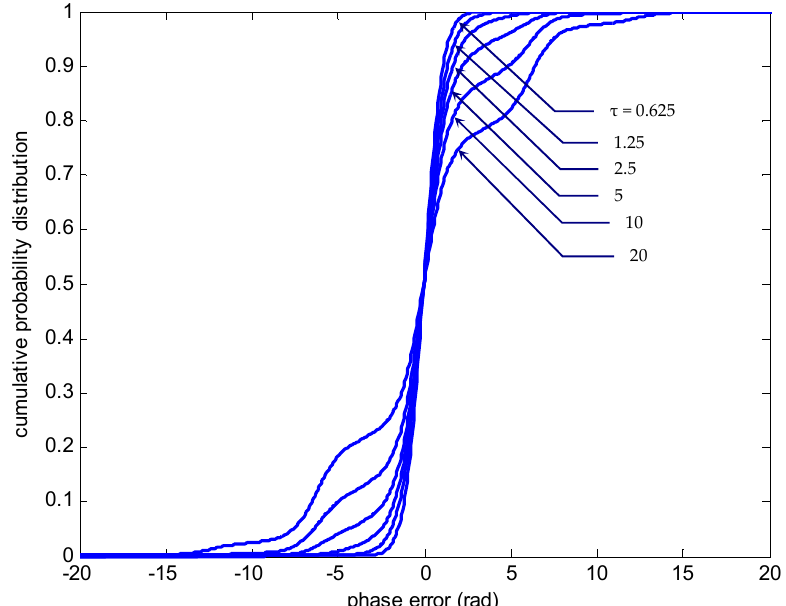
Figure 3. The time-evolution of the nonmodulo-2 π cumulative probability distribution of the phase error for SNR α = 1 ( γ = 0).